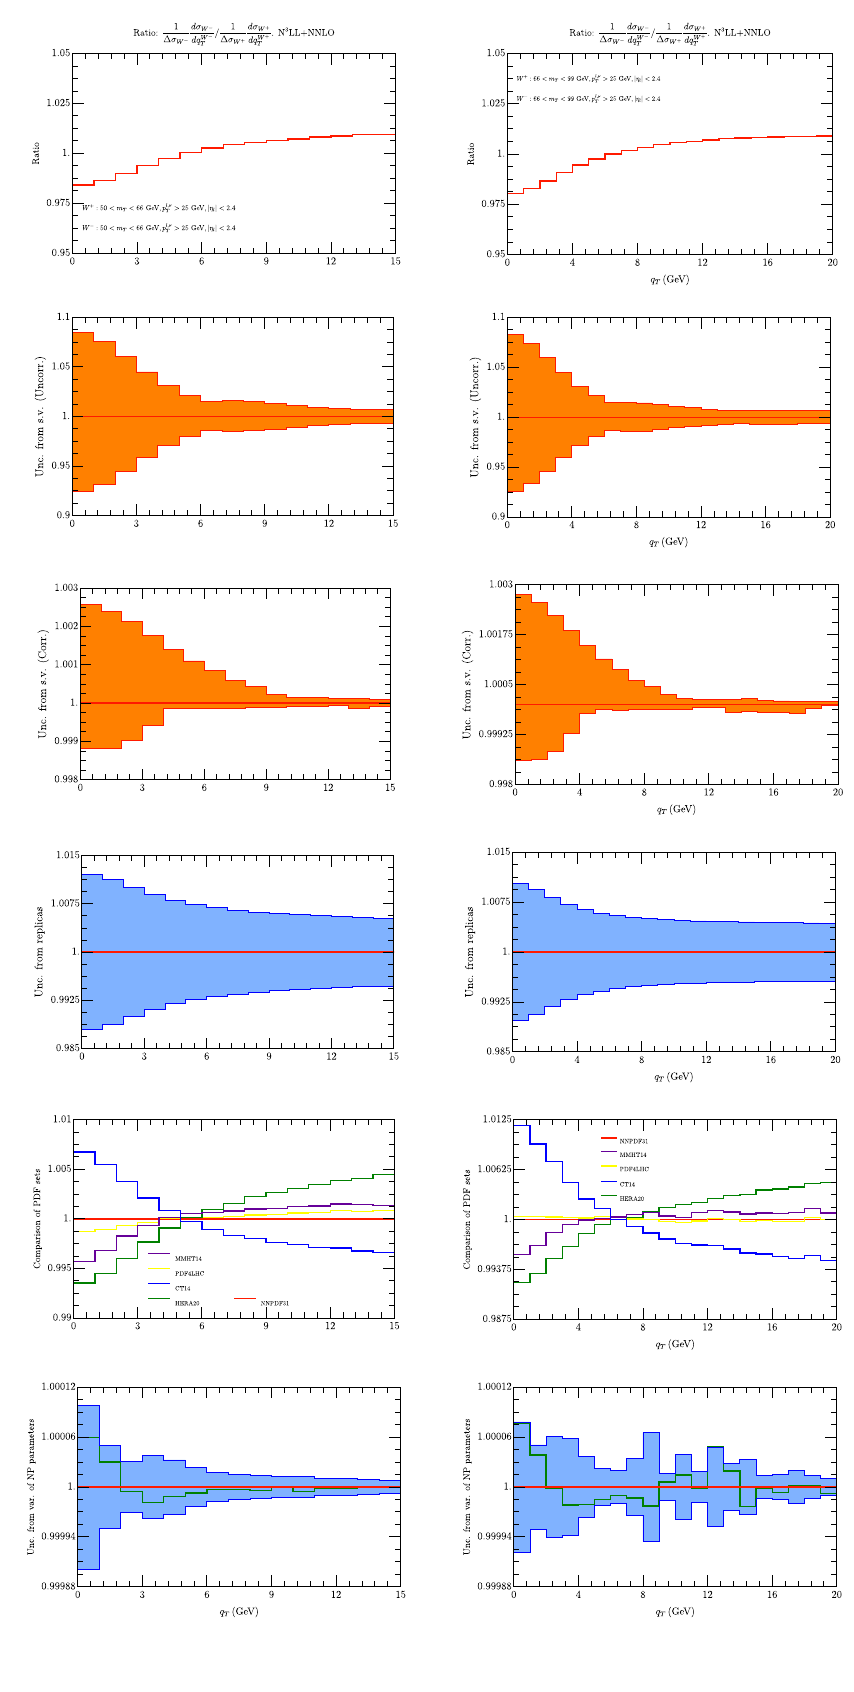
Fig. 6 Ratio of W − / W + spectrum for m T ∈ [ 50 , 66 ] GeV (left column) , and m T ∈ [ 66 , 99 ] GeV (right column). On the first row we have the W − / W + spectrum using the central replica of NNPDF31_nnlo_as_0118 [28]. Uncorrelated and correlated theoretical uncertainties are given in second and third row respectively. In the third line we have the error calculated as a variance in each bin of 100 replicas of the set NNPDF31_nnlo_as_0118 [28]. The uncertainty is referred to the average value of each bin (red line). The value of the observable given by the central replica is undistinguishable from the red line. On the fourth line we represent the value of each been with different sets of PDF. On the fifth row we have the uncertainty due to non-perturbative